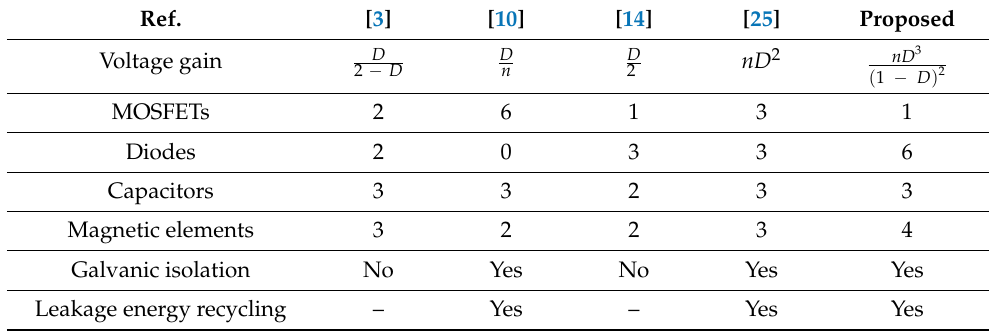
Table 1. Performance comparison among the proposed converter and other recently proposed topologies.